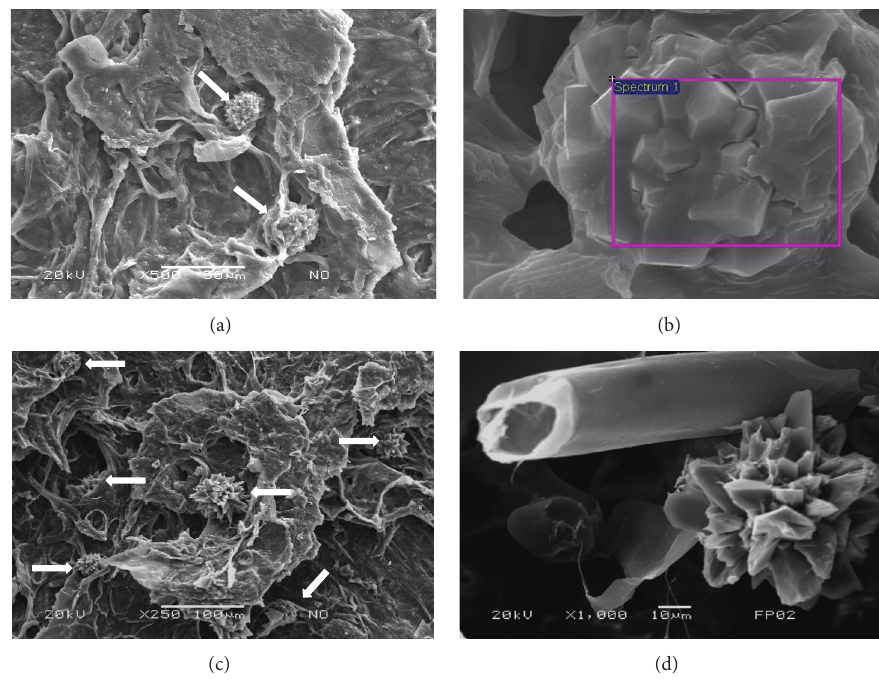
Figure 1: SEM images of cladodes and insoluble dietary fiber of O. ficus indica , (a) calcium oxalate crystals (whewellite) in O. ficus indica cladodes, (b) calcium oxalate crystals (weddellite) in O. ficus indica cladodes, (c) calcium oxalate crystals in insoluble dietary fiber extracted from O. ficus indica , and (d) vessel from the xylem of O. ficus indica with a calcium oxalate crystal (whewellite).